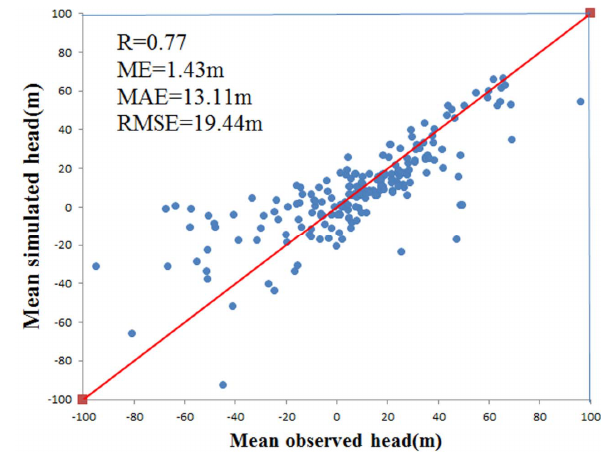
Fig. 6. Scatter plot of averaged simulated and observed groundwater Fig.6. Scatter plot of averaged simulated and observed groundwater heads for the entire 226 1021 heads for the entire 226 observation wells. Each point represents a observation wells. Each point represents a value of average simulated/observed head for a 1022 value of average simulated/observed head for a well. The points well. The points that lack observed head data have been rejected from the figure. The 1023 that lack observed head data have been rejected from the figure. performance criteria values (R, ME, MAE and RMSE) are also shown in the figure. 1024 The performance criteria values ( R , ME, MAE and RMSE) are also shown in the 1025